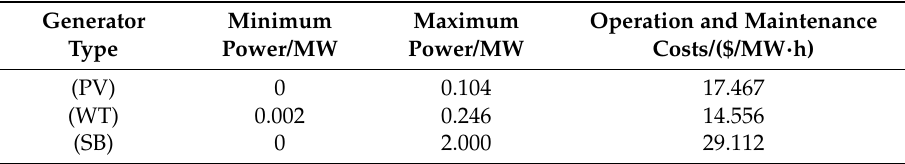
Table 1. Distributed power parameters of microgrid.